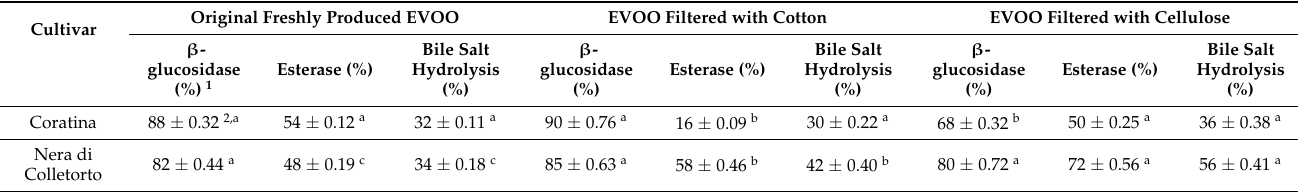
Table 7. Dominance of enzyme-producing yeast with probiotic features, in EVOO subjected to filtration.